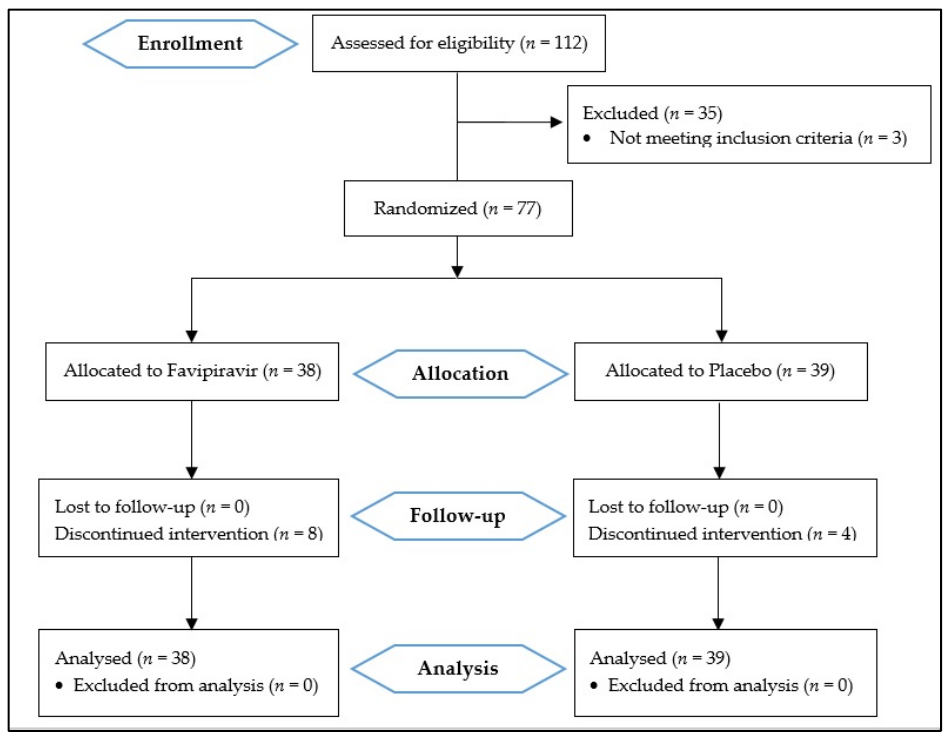
Figure 1. Consolidated standards of reporting trials (CONSORT 2010) flow diagram.